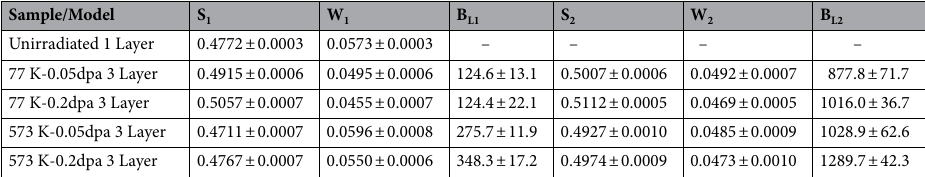
Table 3. Calculated S-& W-parameters and layer boundaries (BL, nm ) using VEPFIT.